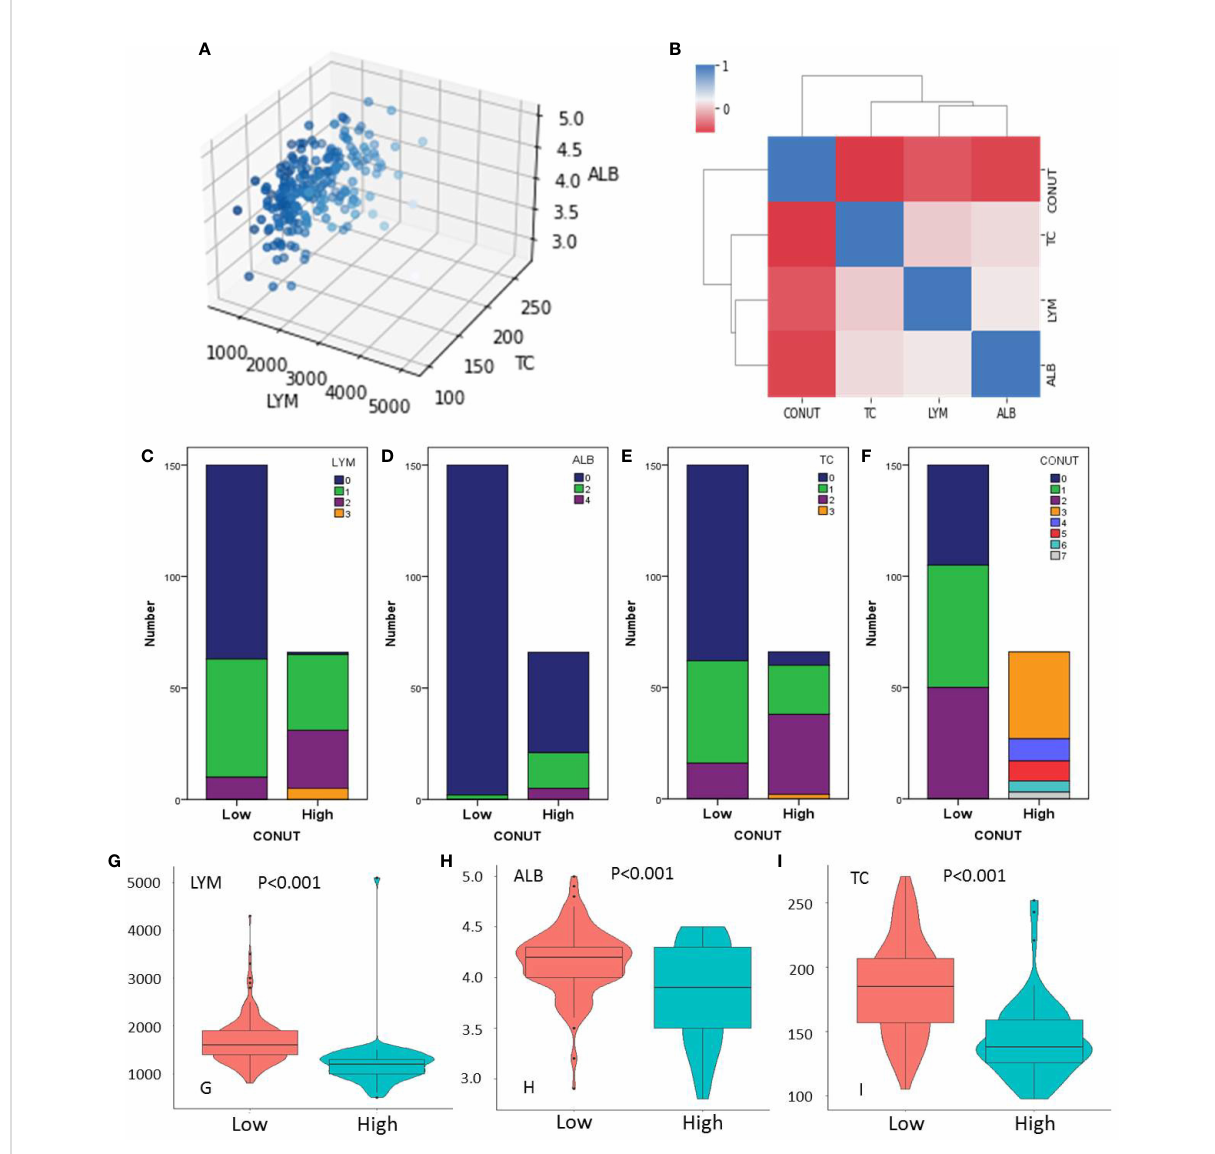
FIGURE 2 Three-dimensional scatter (A) and heat map diagram ( B ). Number of cases based on the lymphocyte (LYM) (C) , albumin (ALB) (D) , total cholesterol (TC) (E) , and CONUT (F) . The levels of LYM (G) , ALB (H) , and TC (I) grouped by